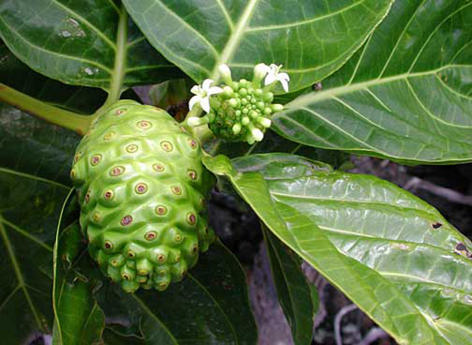

Morinda citrifolia. (Photo: NPS/Bryan Harry)